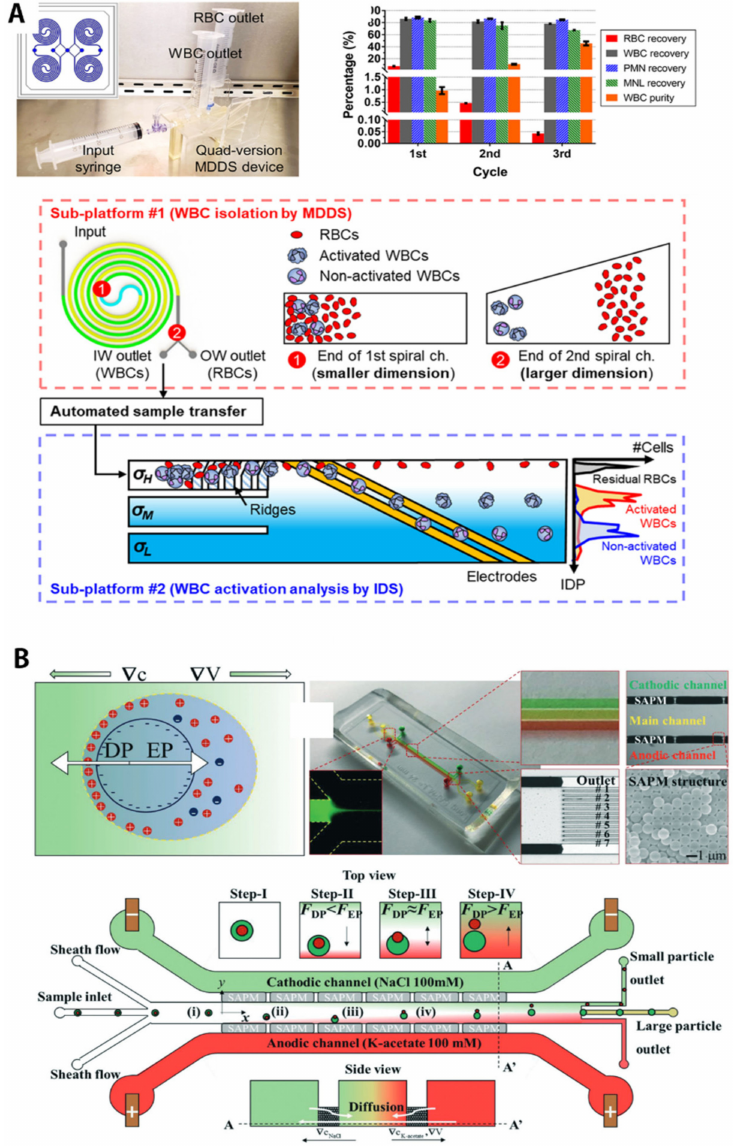
Figure 6. Next-generation microfluidic sample preparation techniques toward high-throughput and high-resolution bioparticle separation with minimal sample damage based on massively parallelized, multiround, and multiphysical separation. ( A ) Multiparallelized and multiround separation for high-throughput isolation of target cells from biosamples with high complexity. Reprinted with permission from the American Chemical Society [40]; ( B ) Multiphysical approach based on combi- nation of passive and active separation mechanisms to minimize sample damage and side effects associated with high electrical field strengths. Reprinted with permission from the Royal Society of Chemistry [41]. All rights